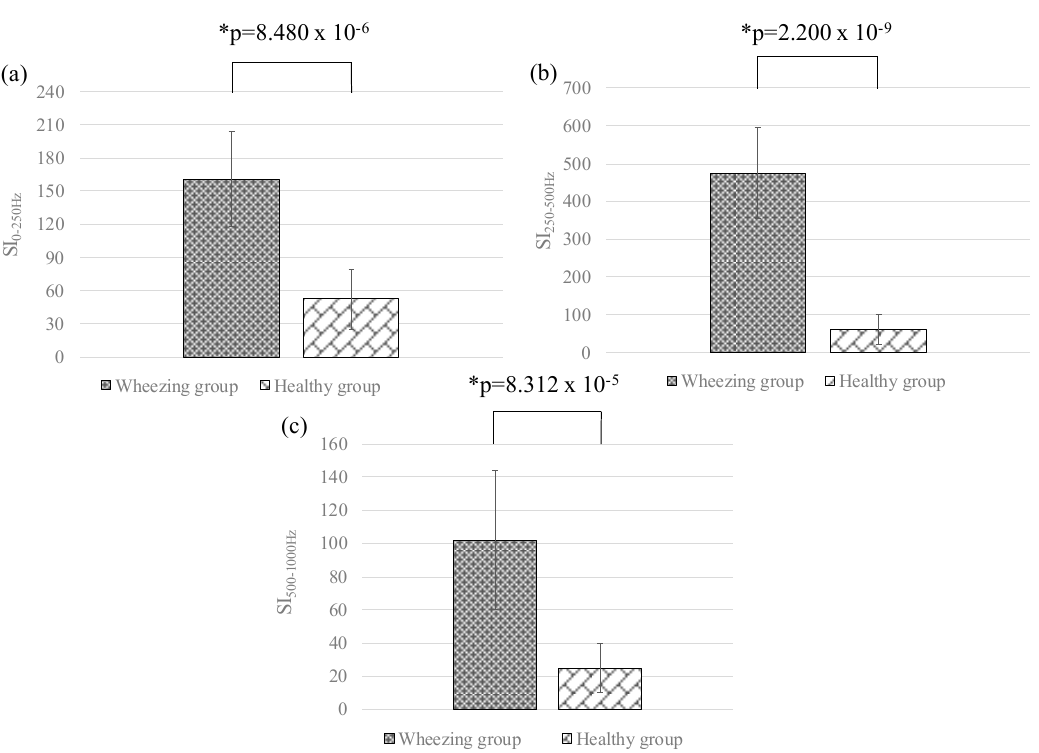
Figure 8. Means and standard deviations of ( a ) NSI 0Hz-250Hz ; ( b ) NSI 250Hz-500Hz ; and ( c ) NSI 500Hz-1000Hz for different groups. Here, * denotes significant difference.